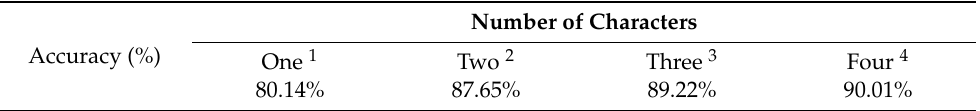
Table 2. Verification accuracy through multimodal.